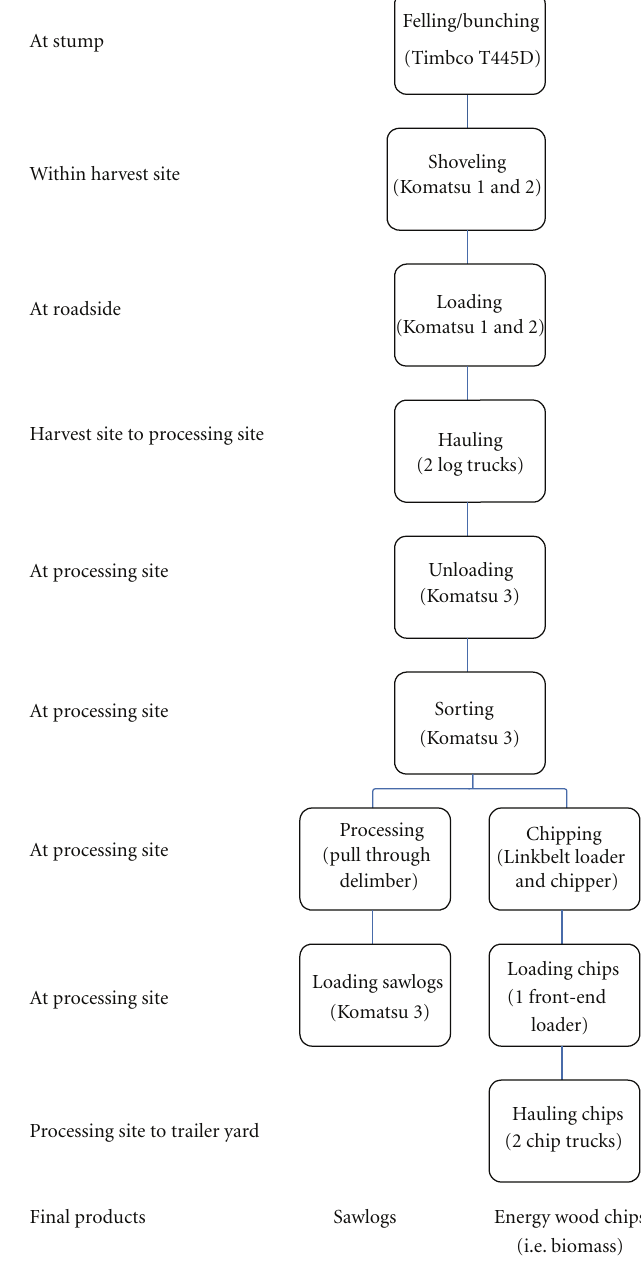
Figure 2: Integrated harvesting and processing system flow chart. Table 1: Preharvest study unit